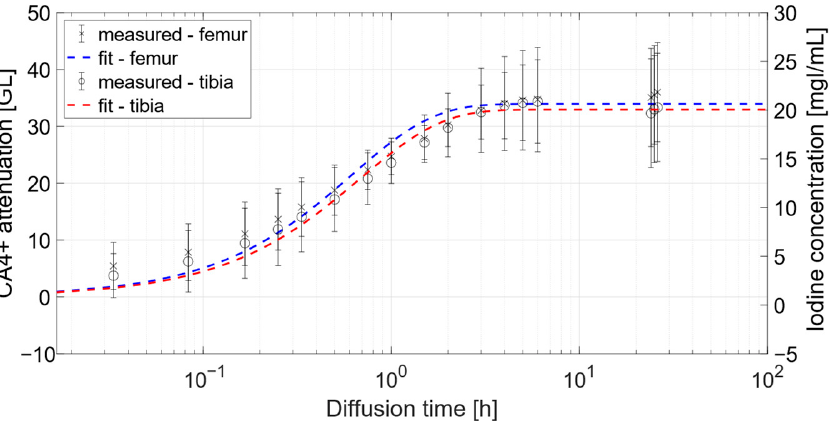
Figure 4. Diffusion curve of CA4+ in femoral (blue) and tibial (red) osteochondral plugs, pointing out